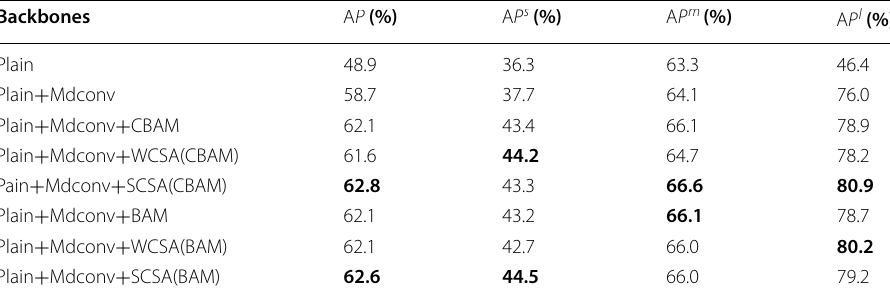
The significance for bold values is only highlighted on the best performance